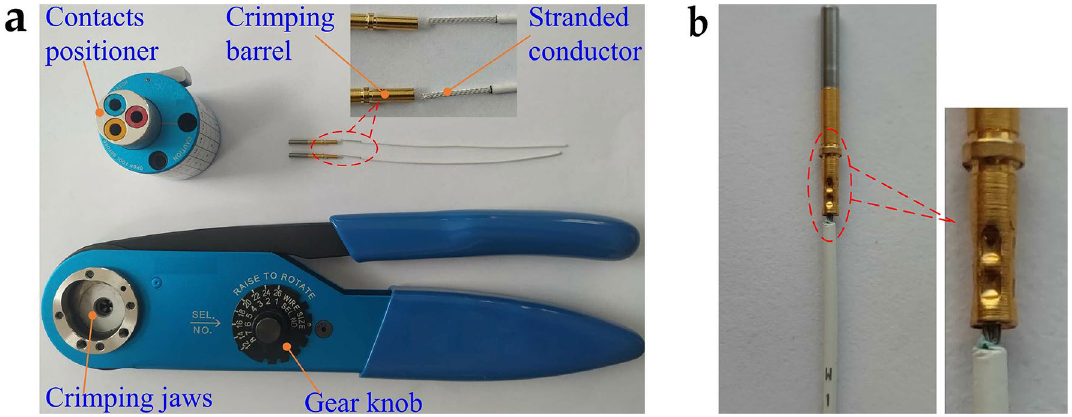
Figure 6. Crimping tools, materials, and crimping samples. Gear No. ( #